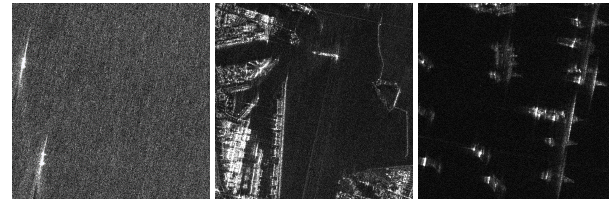
Figure 10. Some samples from the AIR-SARShip-1.0 dataset.